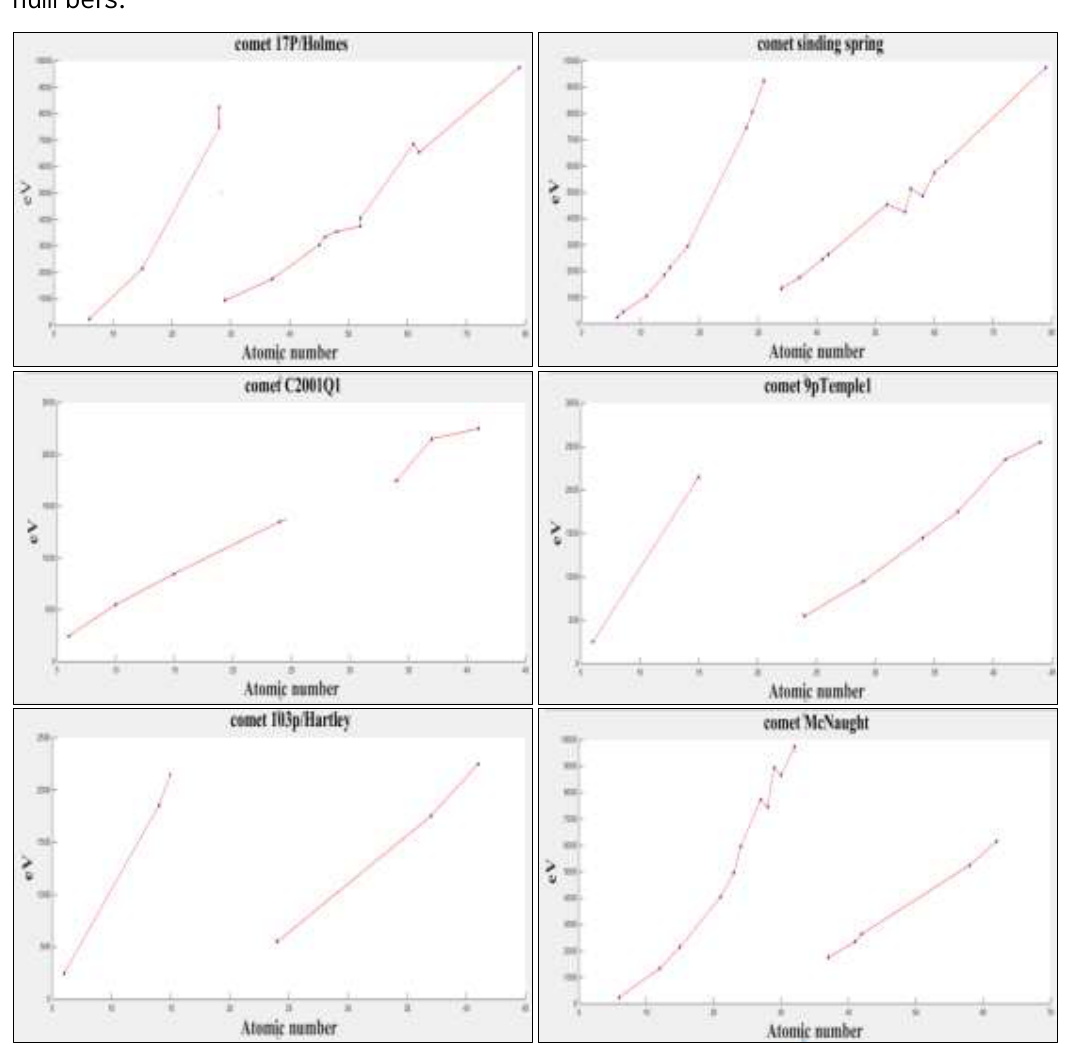
Figure 3: Energy versus comet’ atomic